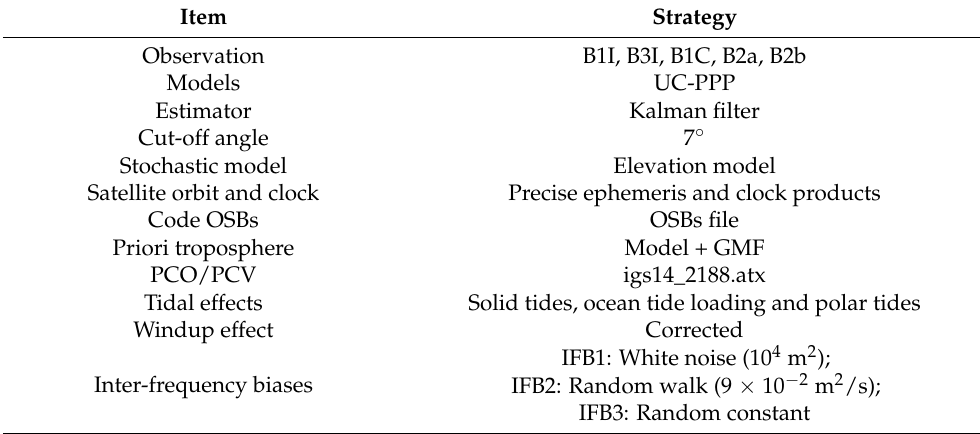
Table 2. The data-processing strategy of BDS-3 UC-PPP for five-frequency observations.